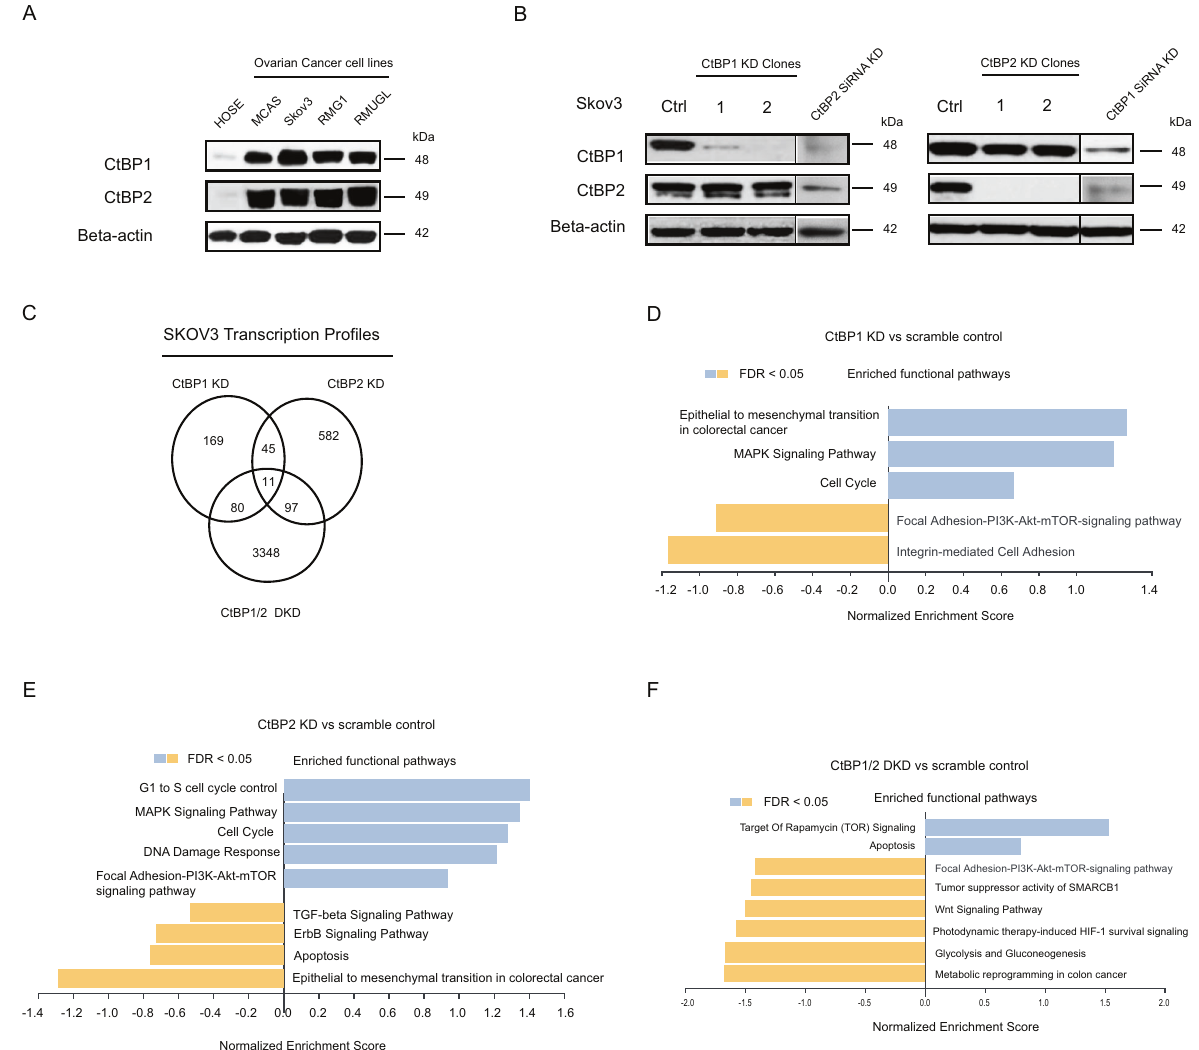
knockdown (Fig. 1B). Similar to our previous fi ndings [21], speci fi c single knockdown of the CtBP1 or CtBP2 gene did not signi fi cantly induce isoform gene compensatory expression. Transiently dual CtBP1/2 knockdown had been achieved by a 48-h swap of CtBP1/ 2 siRNA interference in CtBP1/2 stable knockdown cancer cells, and validated by western blot analysis (Fig. 1B). Transcriptome analysis discovered key functions regulated by CtBP1/2 proteins Normalized and fi ltered through comparison, 355 genes (upregu- lated 182 genes; downregulated 173 genes; CtBP1 KD vs. control, Fig. S1A), 805 genes (upregulated 784 genes; downregulated 21 genes; CtBP2 KD vs. control, Fig. S1B) and 4297 genes (upregulated 1364 genes; downregulated 2933 genes; CtBP1/2 DKD vs. control, Fig. S1C) had been identi fi ed as signi fi cantly changed genes and computationally clustered, respectively. A Venn diagram demonstrated the overlapped signi fi cantly changed genes among three knockdown groups (Fig. 1C). Different groups shared a variety of common genes, including